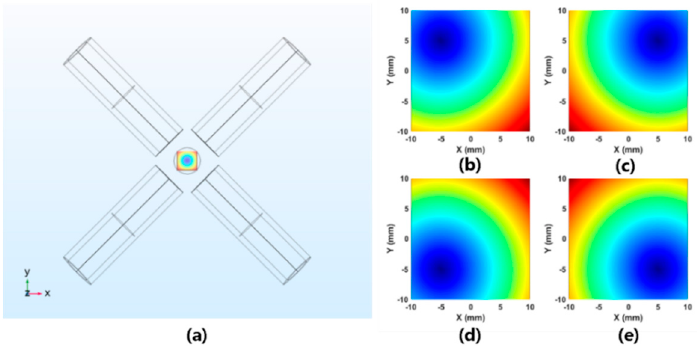
Figure 2. The simulated field-free point (FFP) obtained from COMSOL on the XY-plane. ( a ) A simulation model of the proposed system. ( b – e ) The flexible mobility of the proposed FFP actuation structure in the system. The FFP is located at ( − 5,5) in ( b ), (5,5) in ( c ), ( − 5, − 5) in ( d ), and (5, − 5) in ( e ).